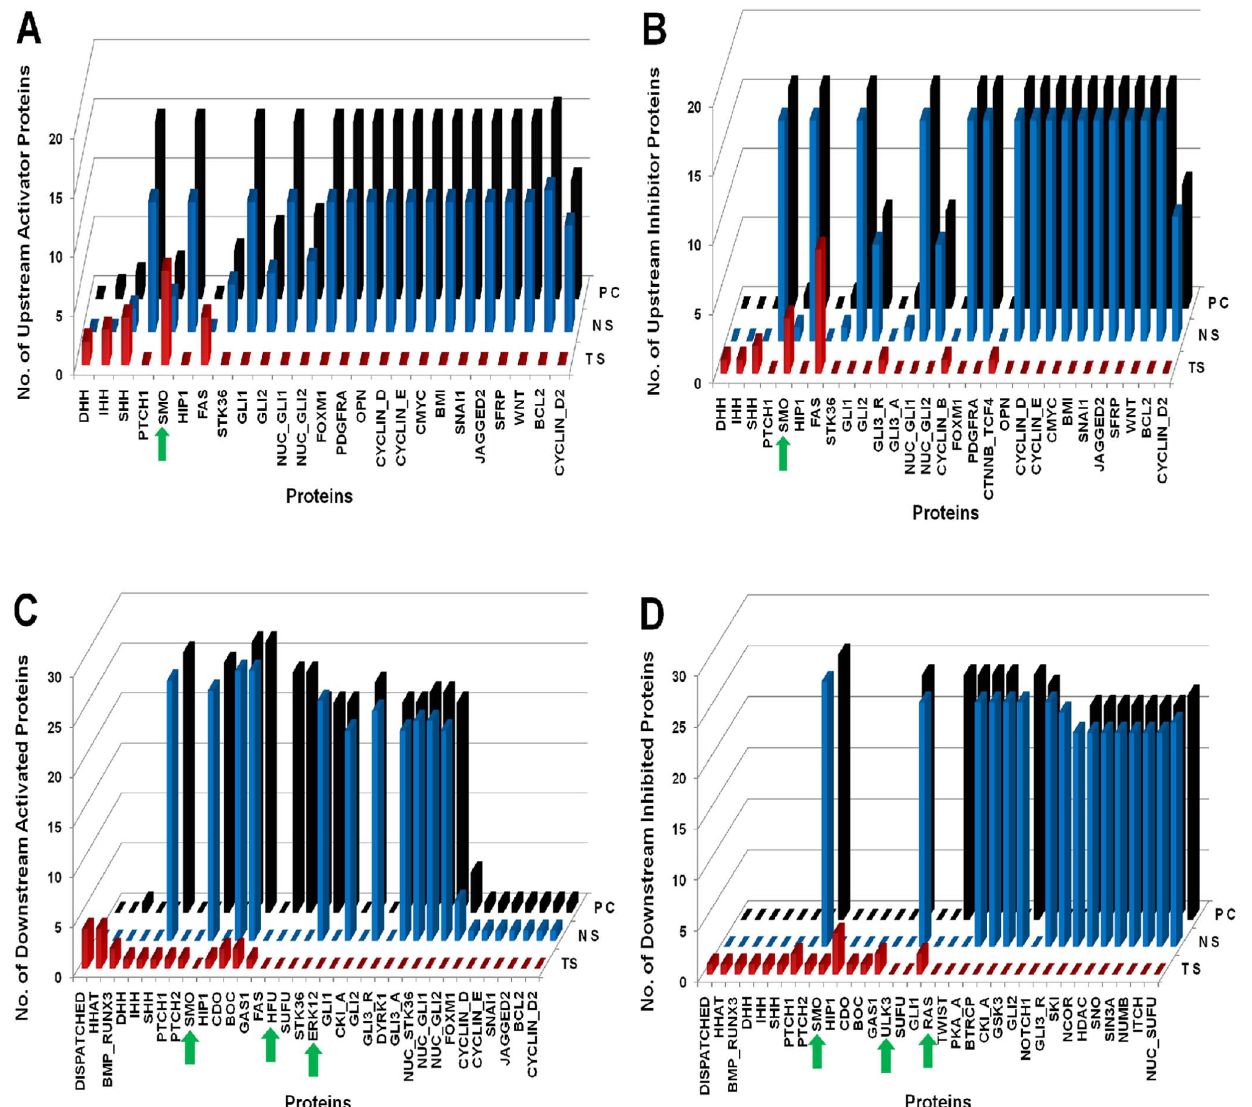
Figure 6. Comparison between Normal, Cancer and Perturbed scenarios for Pancreatic Cancer. TS: Treated Scenario; NS: Normal Scenario; PC: Pancreatic Cancer Scenario. The green arrow heads are indicating the minimal combination of proteins which was inhibited in the drug treated perturbation analysis. (A) Represents number of Upstream activator proteins (Y-axis) activating the proteins (X-axis) representing significant variations. Compared to the normal scenario, proteins, SHH, IHH, SMO, GLI1, GLI2 and output proteins BMI, SNAI1, BCL2 and Cyclins are activated by maximum number of upstream activator proteins. On drug treated perturbation of SMO, HFU, ULK3, RAS and ERK12, the number of activators of the output proteins become zero. (B) Represents number of upstream inhibitory proteins (Y-axis) inhibiting the proteins (X-axis) representing significant variations. The numbers of upstream inhibitor proteins in normal versus Pancreatic cancer scenario remain same. Similar perturbation results are observed as in (A). (C) Represents number of downstream proteins (Y-axis) activated by the proteins (X-axis) representing significant variations. The numbers of downstream proteins activated in normal versus Pancreatic Cancer remain same. On perturbation of SMO, HFU, ULK3, RAS and ERK12, the number of downstream proteins activated by these proteins is reduced to zero. (D) Represents number of downstream proteins (Y-axis) inhibited by the proteins (X-axis) representing significant variations. The numbers of downstream proteins inhibited in normal versus Pancreatic cancer scenario remain